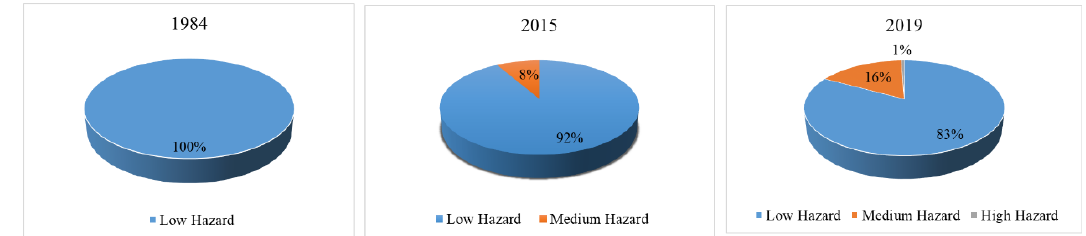
Figure 16. The exposed percentage areas for the flood hazard levels over time from 1984 to 2019 in Drunka.